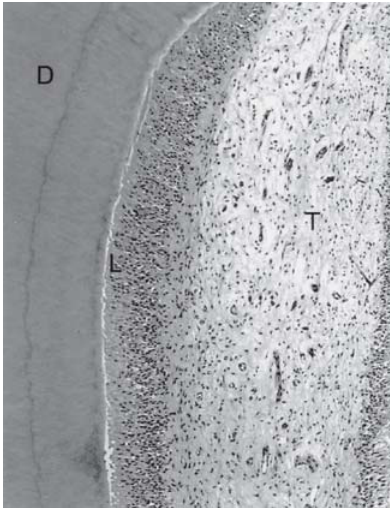
FIGURE 4- Group II (Calcium hydroxide): normal dentine (D), odontoblastic layer (L) and connective pulp tissue (T). (hematoxylin and eosin - X 40)